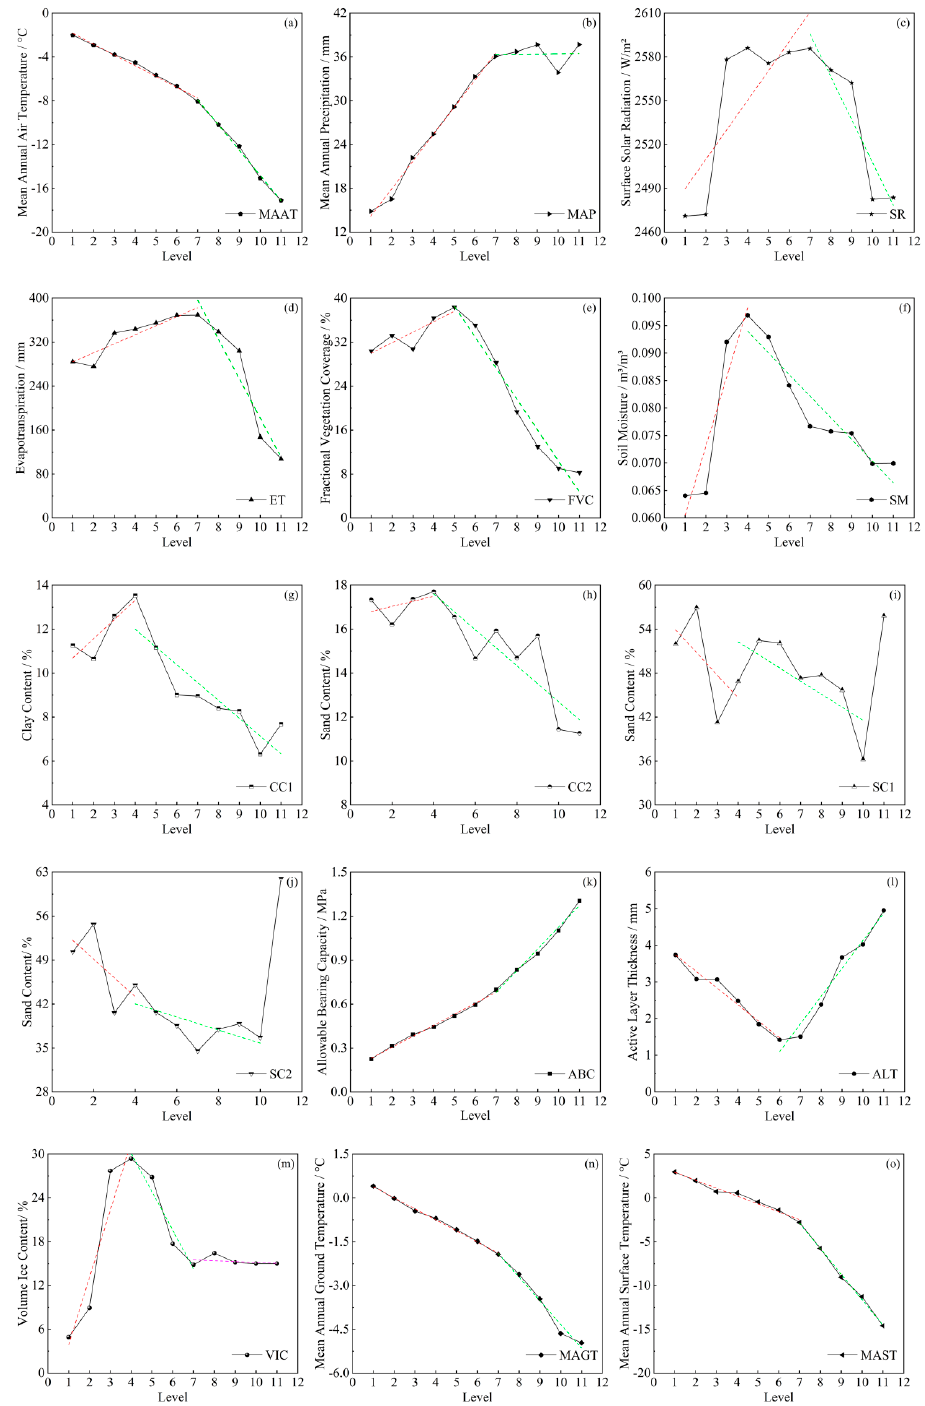
Figure 5. Changes in risk factors considering elevation: ( a ) MAAT; ( b ) MAP; ( c ) SR; ( d ) ET; ( e ) FVC; ( f ) SM; ( g ) CC1; ( h ) CC2; ( i ) SC1; ( j ) SC2; ( k ) ABC; ( l ) ALT; ( m ) VIC; ( n ) MAGT; ( o )